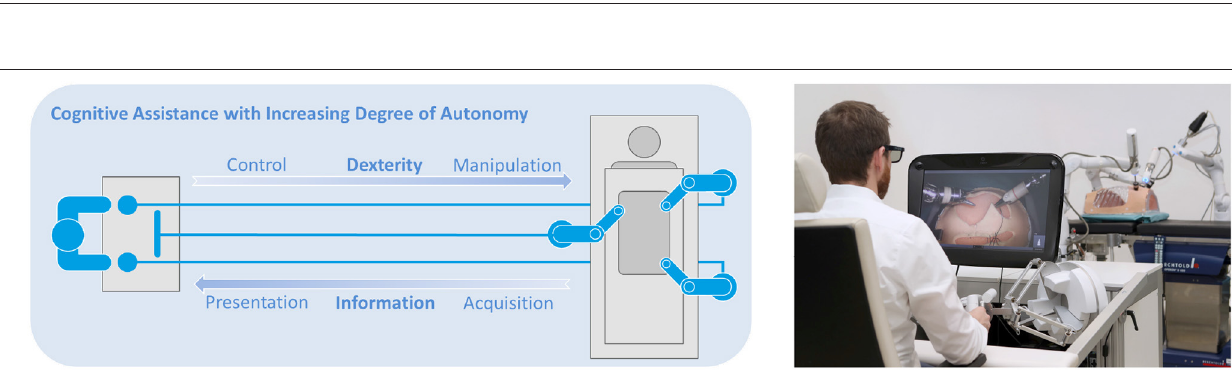
FIGURE 11 | (Left) Concept of the caregiving ecosystem SMiLE . (Right) Exemplary implementation (Vogel et al., 2020). [ © 2020 IEEE. Reprinted, with permission, from ( Vogel et al., 2020)].